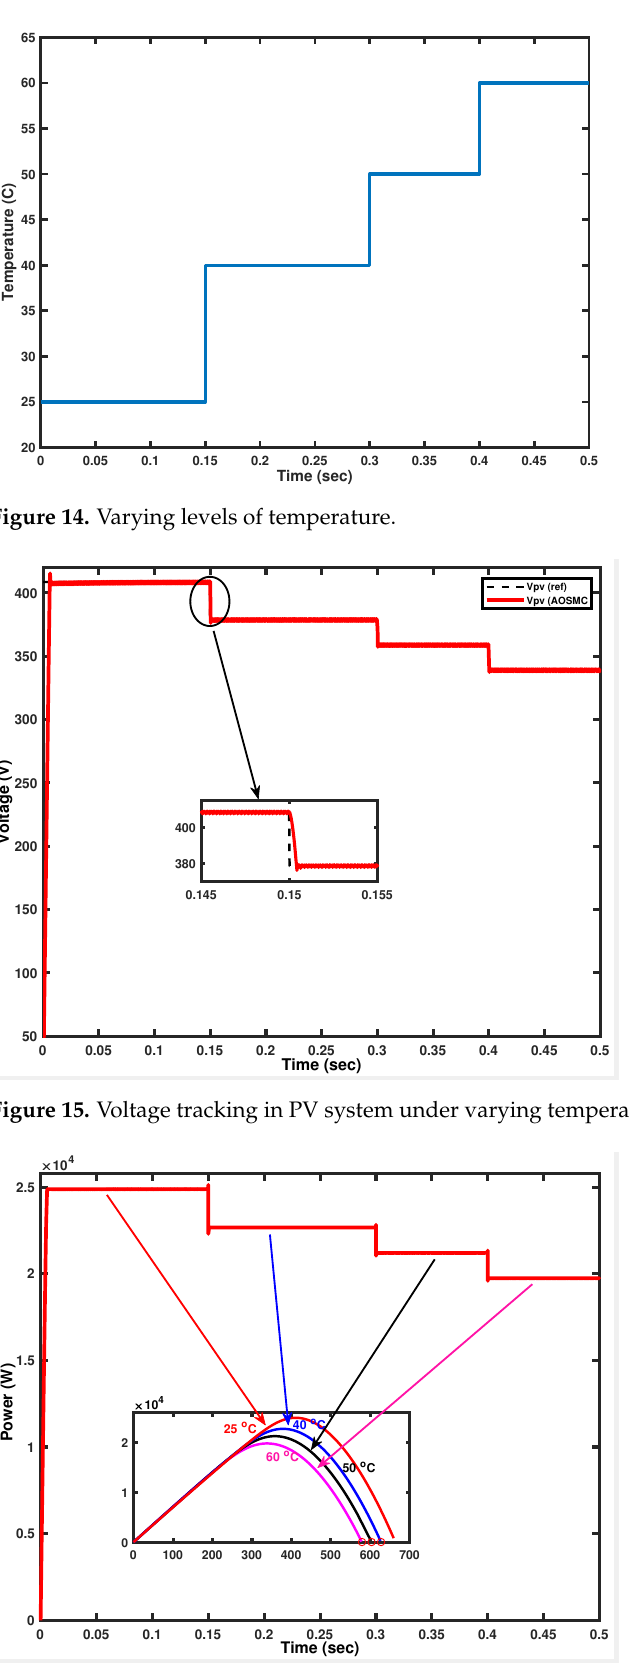
Figure 16. The PV output power under varying